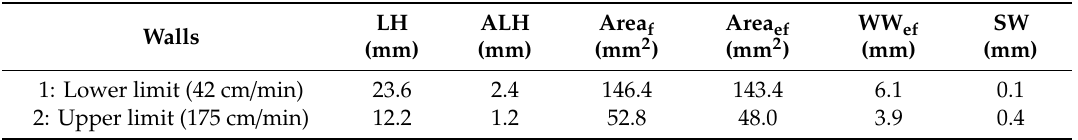
Table 1. Geometrical parameters of the built